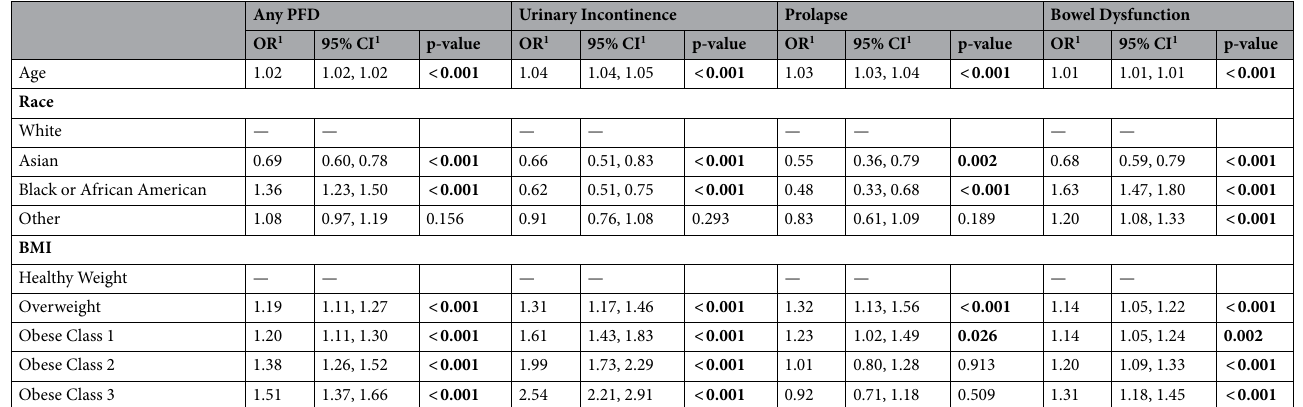
Table 3. Multivariable analysis of clinical characteristics and presence of pelvic floor disorders. Significant values are in bold. 1 OR = Odds Ratio, CI = Confidence